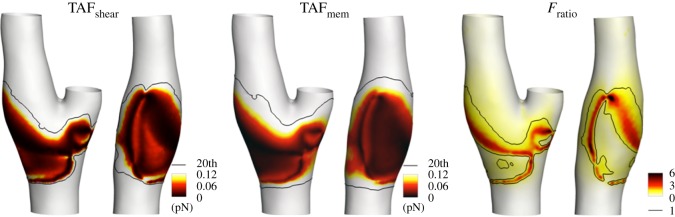
Distributions of the time-averaged shear force (TAFshear), time-averaged membrane force (TAFmem) and their ratio TAFmem over TAFshear (Fratio) at the luminal surface (two different views). White colour represents TAFshear > 0.12 pN, TAFmem > 0.12 pN, Fratio = 0 respectively. The black isoline correspond to the value of the 20th percentile of the descriptor distribution for TAFshear or TAFmem. For Fratio, the isoline correspond to a value of 1 (i.e. TAFmem = TAFshear).